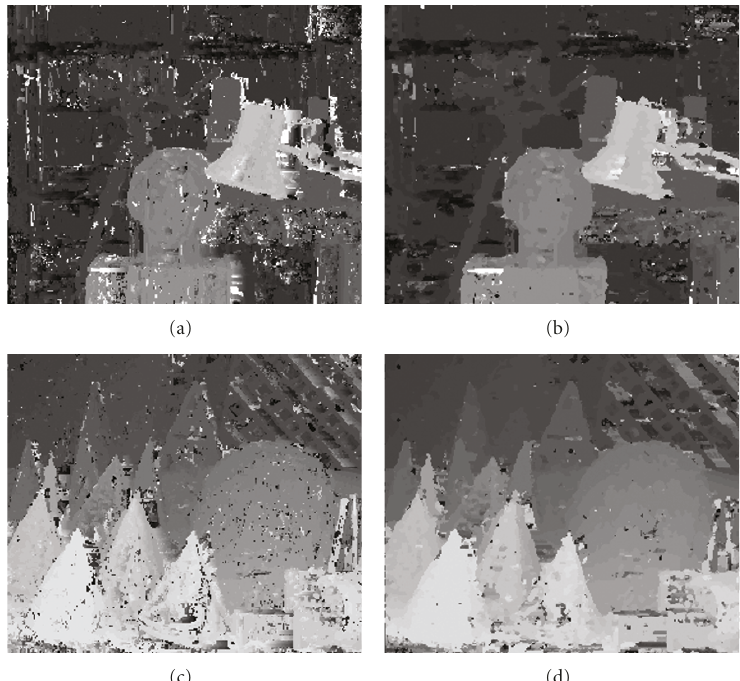
Figure 17: (b) and (d): Results from the SAD-based left-right consistency check. (a) and (c): Depth maps from the plain SAD system, shown for